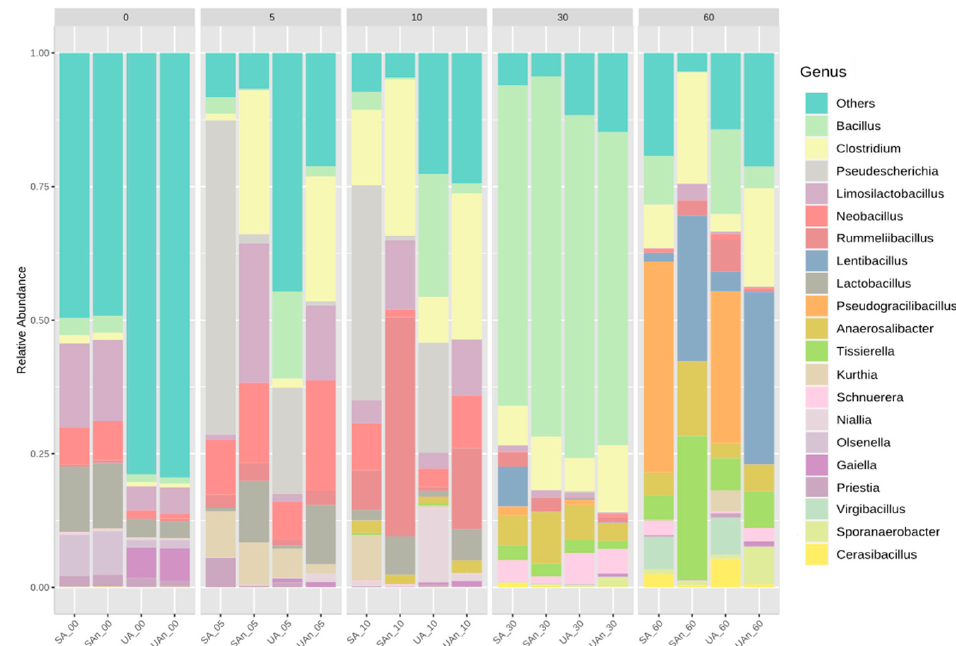
Figure 6. Relative abundance at phylum level during decomposition of poultry carcass. “Others” represent taxa with counts <10. UA, unsterilized soil–aerobic condition; SA, sterilized soil–aerobic condition; UAn, unsterilized soil–anaerobic condition and SAn, sterilized soil–anaerobic condi- tion. The 0, 5, 10, 30, and 60 represent the sampling period.